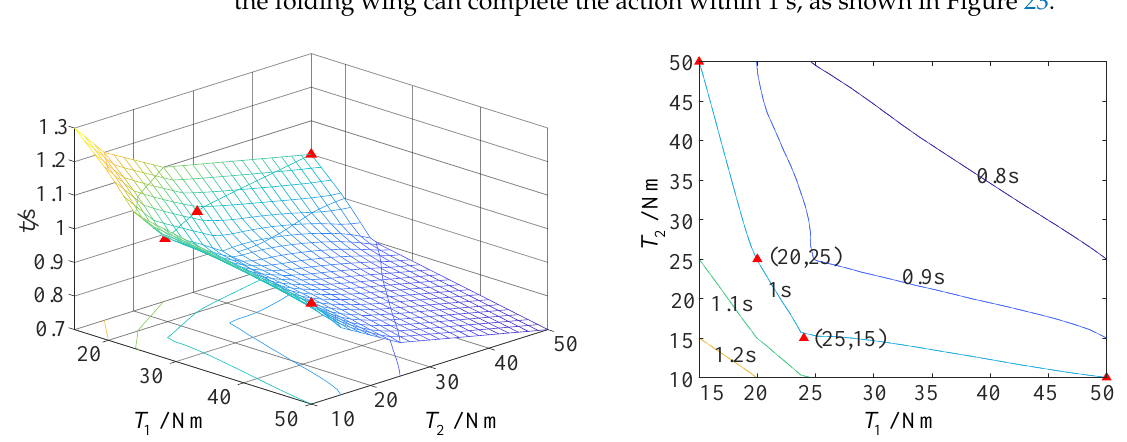
Figure 23. The curve of driving torque and deployment time of folding wing at an airspeed of 30 m/s (fixed-axis – non-fixed-axis stepwise deployment mode).